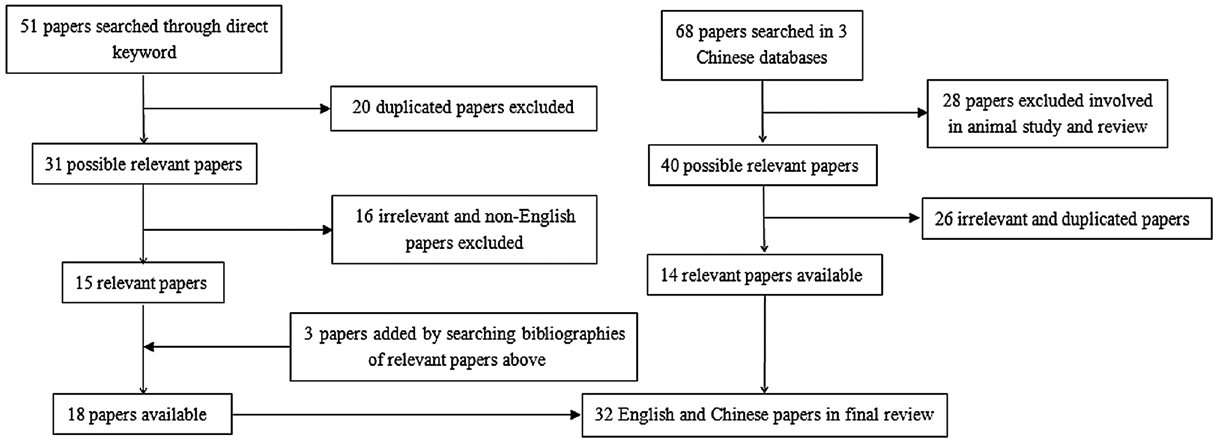
Figure 4. Study selection information regarding human